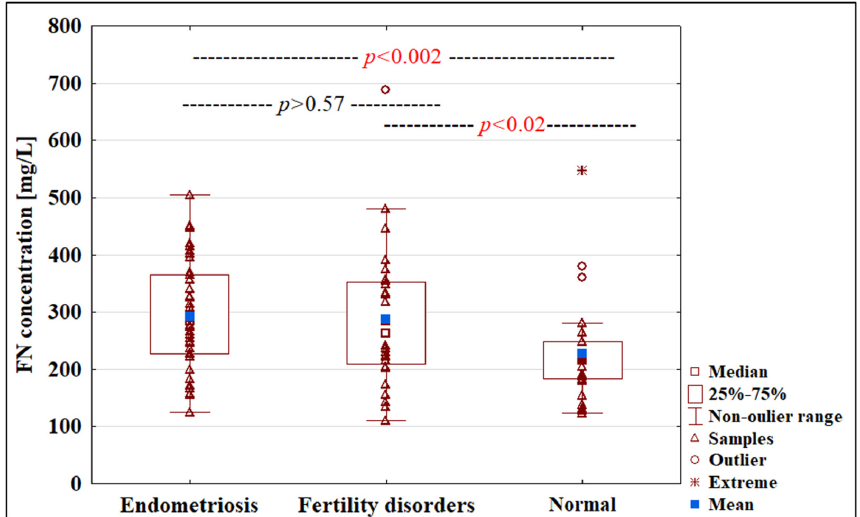
Figure 2. Box plot illustrating the FN concentrations in women’s plasma with endometriosis, fertility disorders and normal groups. The FN concentration were determined as described in Materials and Methods. Data are given as mean values, median and (25th and 75th) quartiles.